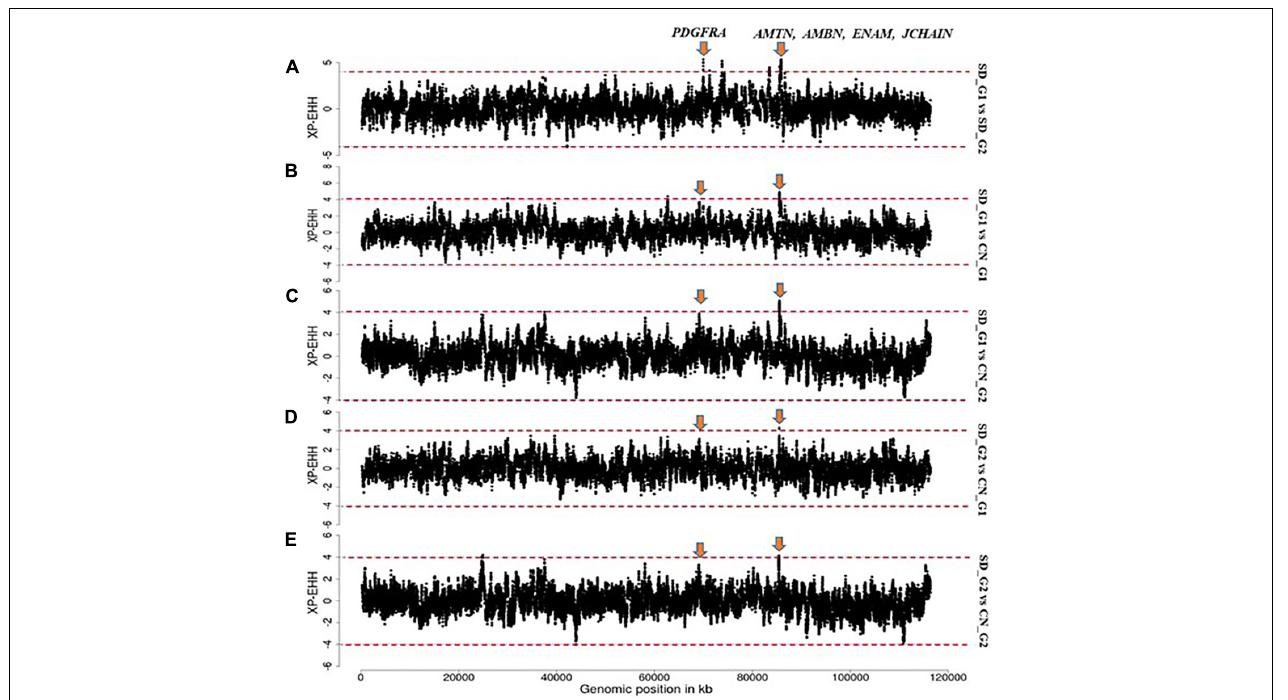
FIGURE 7 | Manhattan plots showing the strongest candidate signatures of selection as determined with XP-EHH on OAR6. (A) SD_G1 vs. SD_G2; (B) SD_G1 vs. CN_G1; (C) SD_G1 vs. CN_G2; (D) SD_G2 vs. CN_G1; (E) SD_G2 vs.